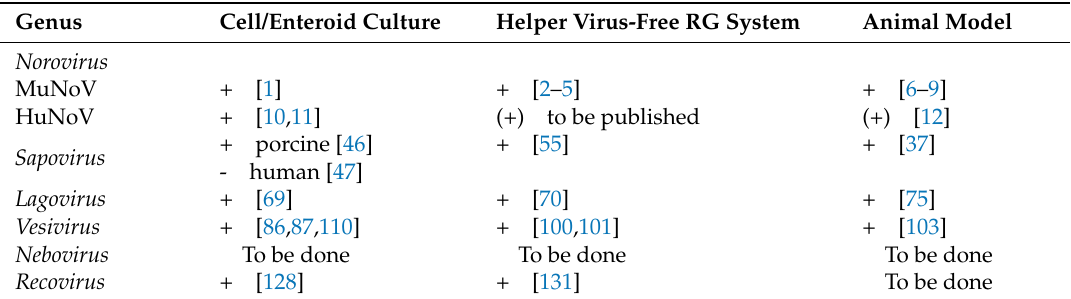
Table 2. Tools available for comprehensive study of different genera of the Caliciviridae . Genus Cell/Enteroid Culture Helper Virus-Free RG